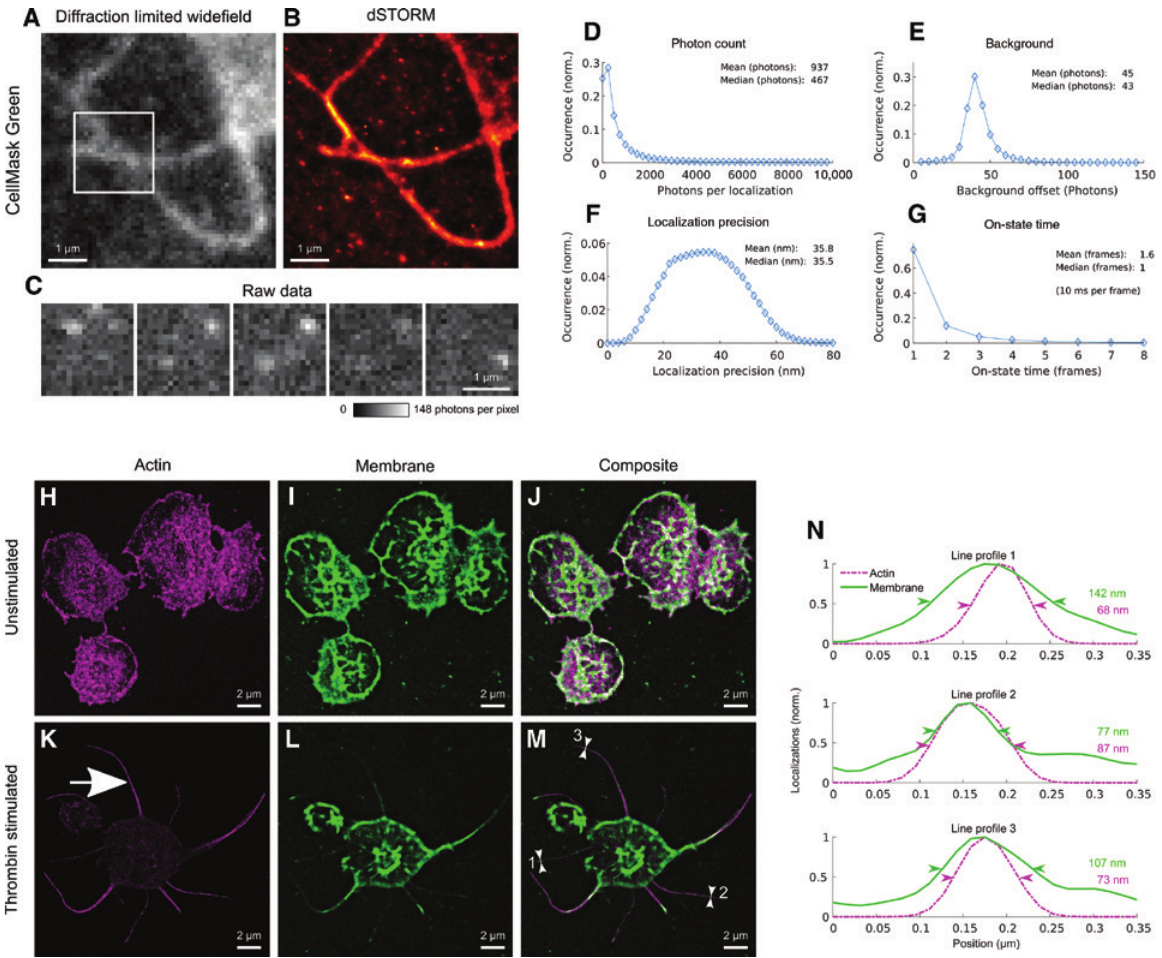
Figure 6: Dual color staining of human platelets. (A) Diffraction limited and (B) dSTORM images of Cell Mask Green stained thrombin-stimulated platelet plasma membrane extensions. (C) Representative raw data of photo-switching Cell Mask Green in subsequent frames of the area indicated by the box in (A). (D–G) The single molecule localization statistics (Cell Mask Green) as photon counts per localization, background, localization precision and on-state-lifetime histograms. (H–M) Dual-color dSTORM images of human unstimulated (H–J) and thrombin stimulated (K–M) platelets stained with phalloidin AF647 (H, K) (purple) and Cell Mask Green (I, L) (green). (J, M) merged phalloidin AF647 and Cell Mask Green images. (N) The line profile analysis of (M) regions 1, 2, and 3 indicated within the figure shows that the ultra-thin membrane projections contain polymerized actin (white arrow in (K)). The numbers report the FWHM values of the membrane and actin structures, respectively. Imaging was performed in TIRF